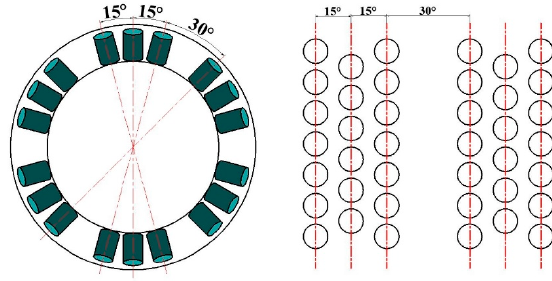
Figure 4. The way the magnets are arranged in RMH.